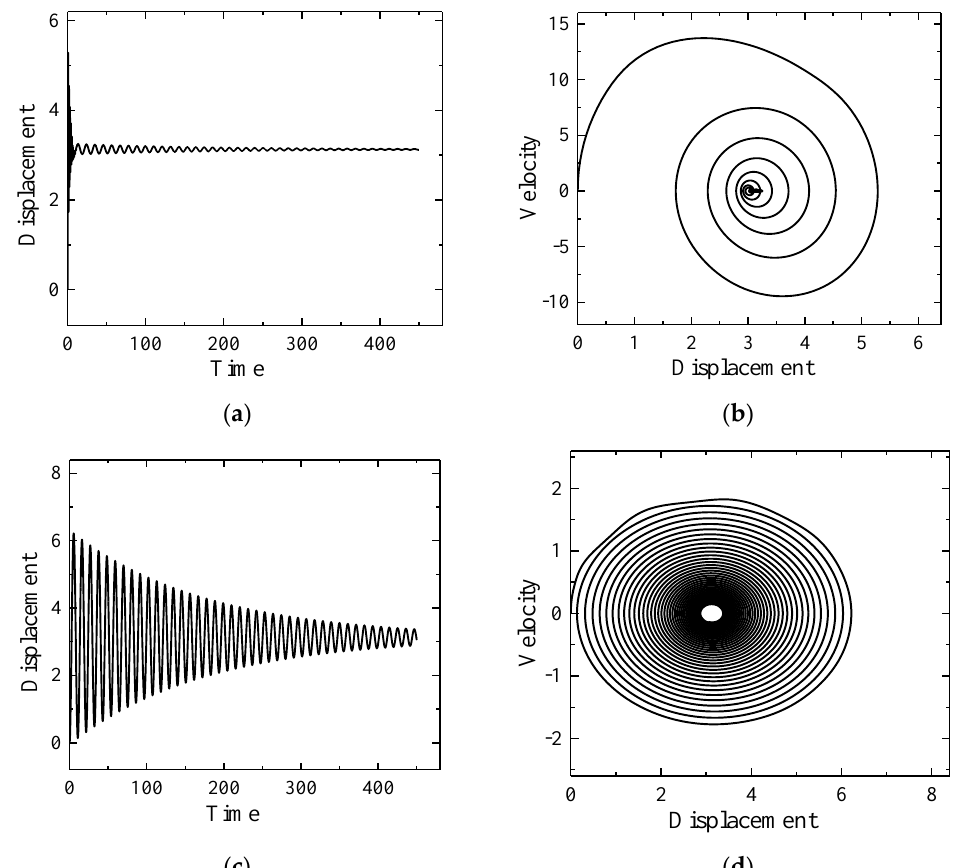
Figure 19. Evolutions of the displacement and speed-displacement diagram of brake disc and brake shoe at the damping of c 1 = c 2 = 0.1 N · s / m. ( a ) Evolution of the displacement of the brake shoe. ( b ) Evolution of the speed-displacement diagram of the brake shoe. ( c ) Evolution of the displacement of the brake disc. ( d ) Evolution of the speed-displacement diagram of the brake disc.